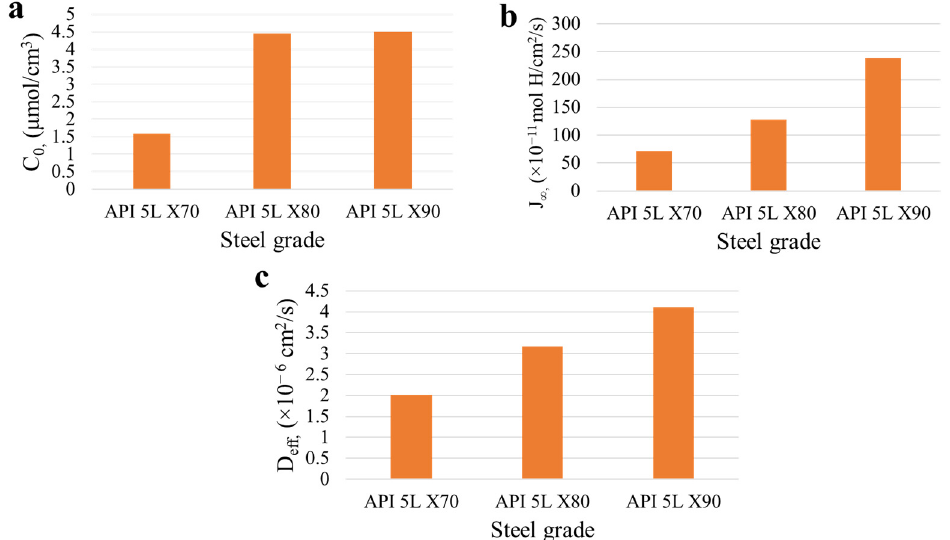
Figure 6. Calculated hydrogen permeation parameters of the different steel grades under applied cathodic potential of − 1200 mV (SCE); ( a ) hydrogen concentration (C 0 ); ( b ) hydrogen permeation flux (J ∞ ); ( c ) effective hydrogen diffusion (D eff ). Data from [51].